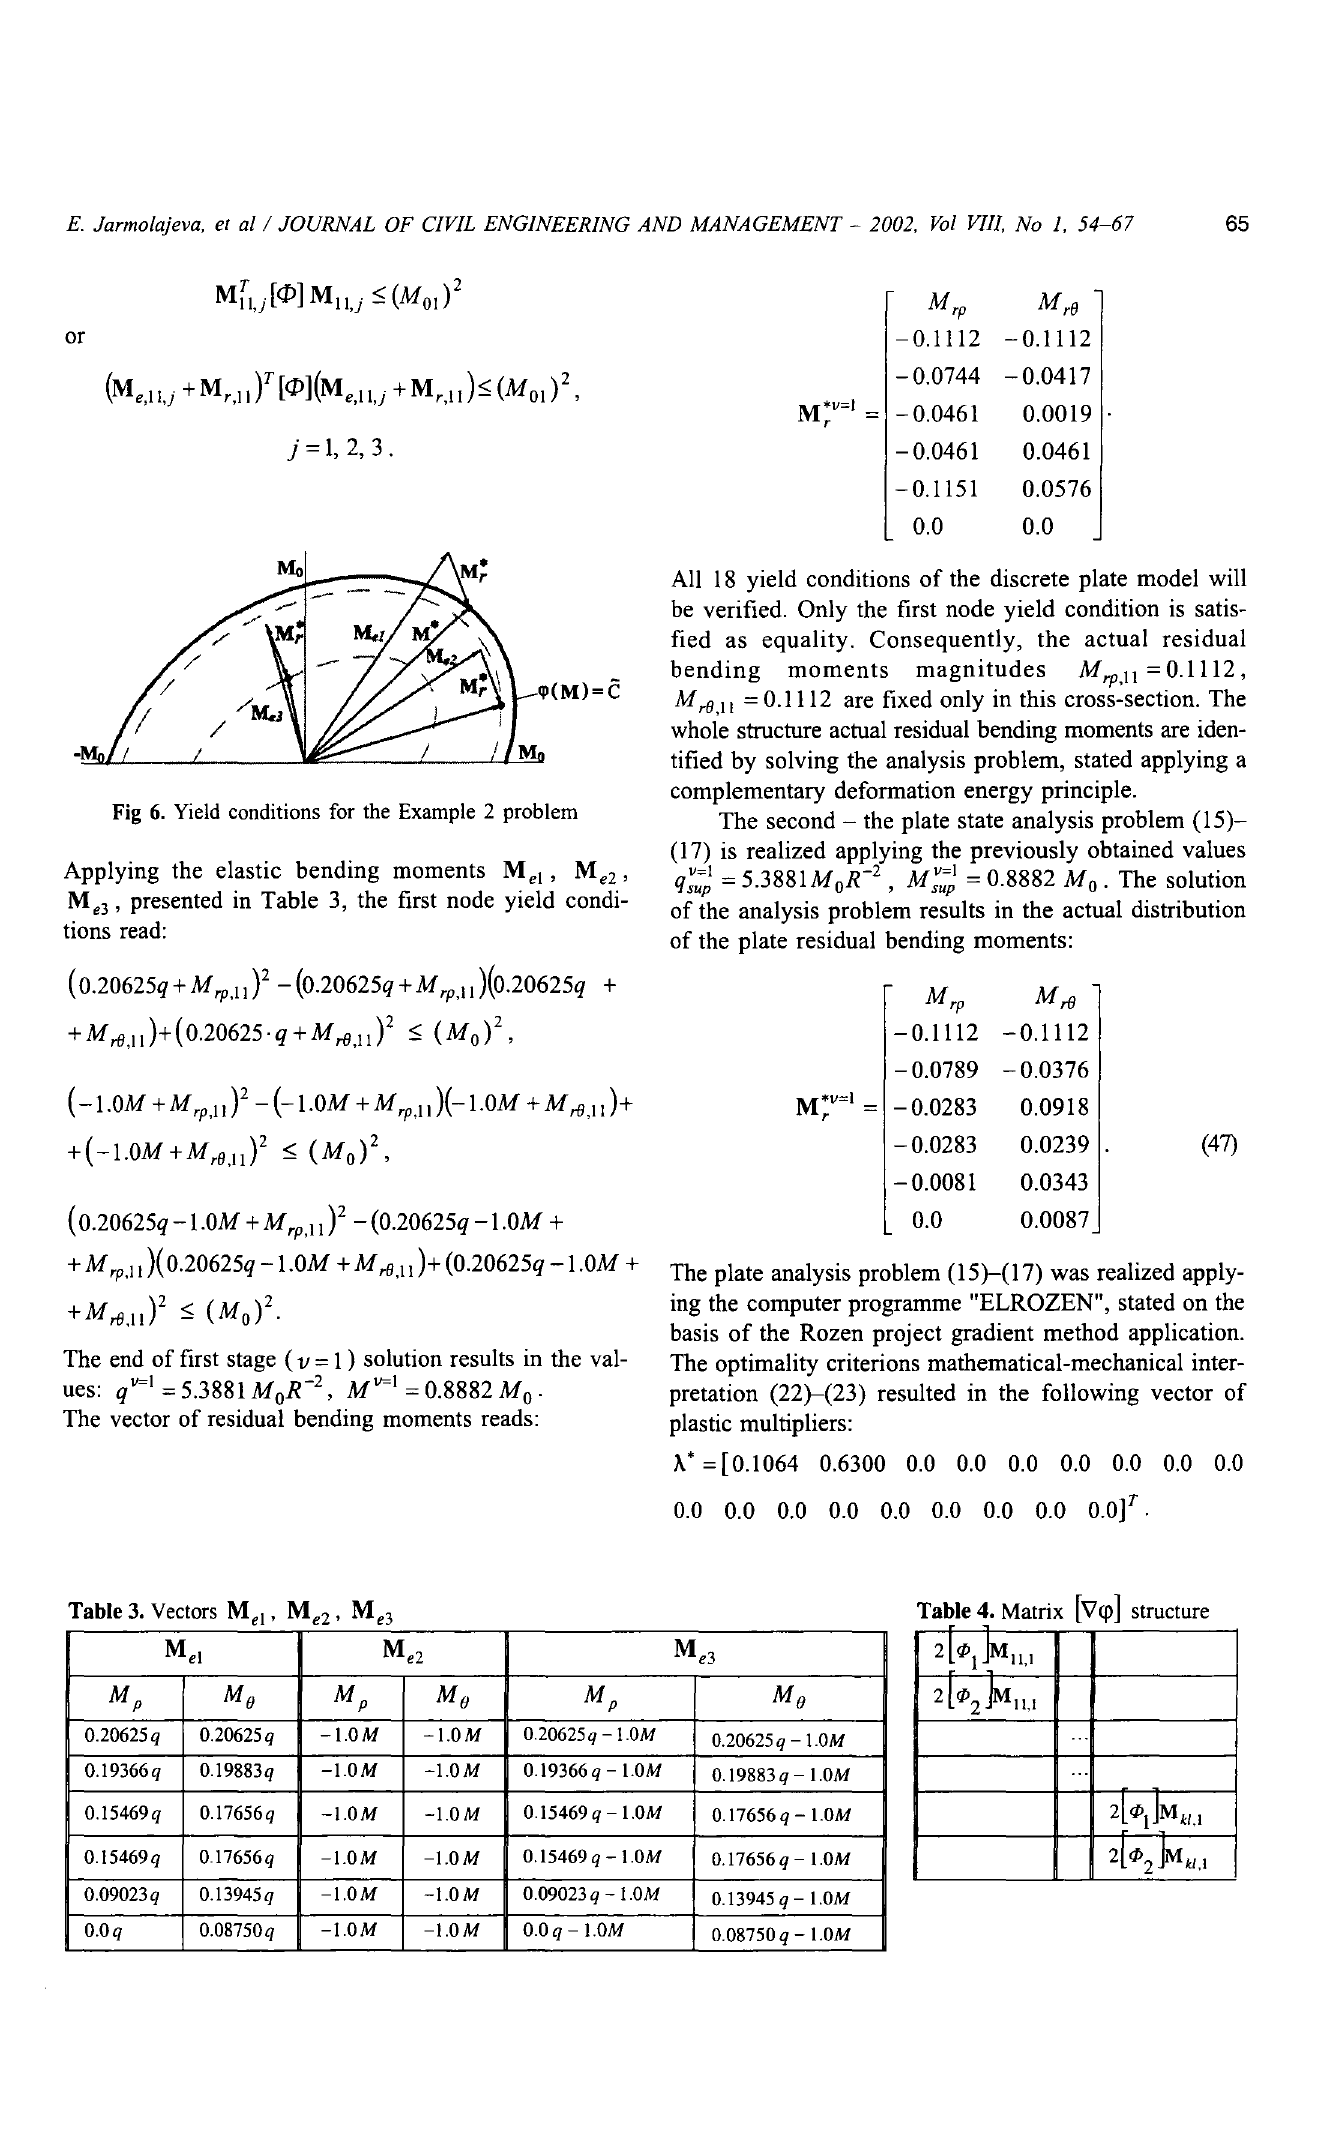
Table 3. Vectors Mel, Mez, Me3 Table 4. Matrix [v cp] structure